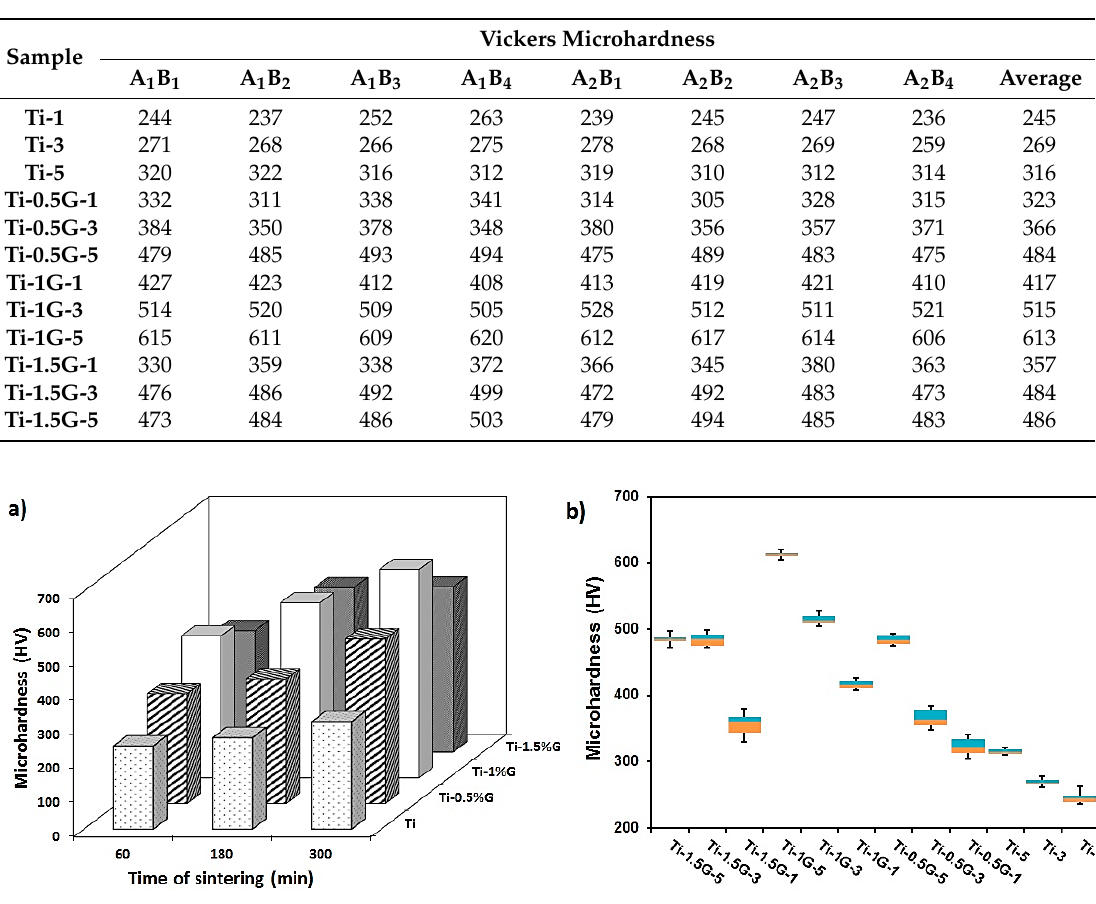
Figure 7. ( a ) 3-D column diagram of the effect of GNSs’ weight percentage on Vickers microhardness of titanium matrix composite sintered at different time periods, and ( b ) Box plot diagram of titanium/graphene composites.